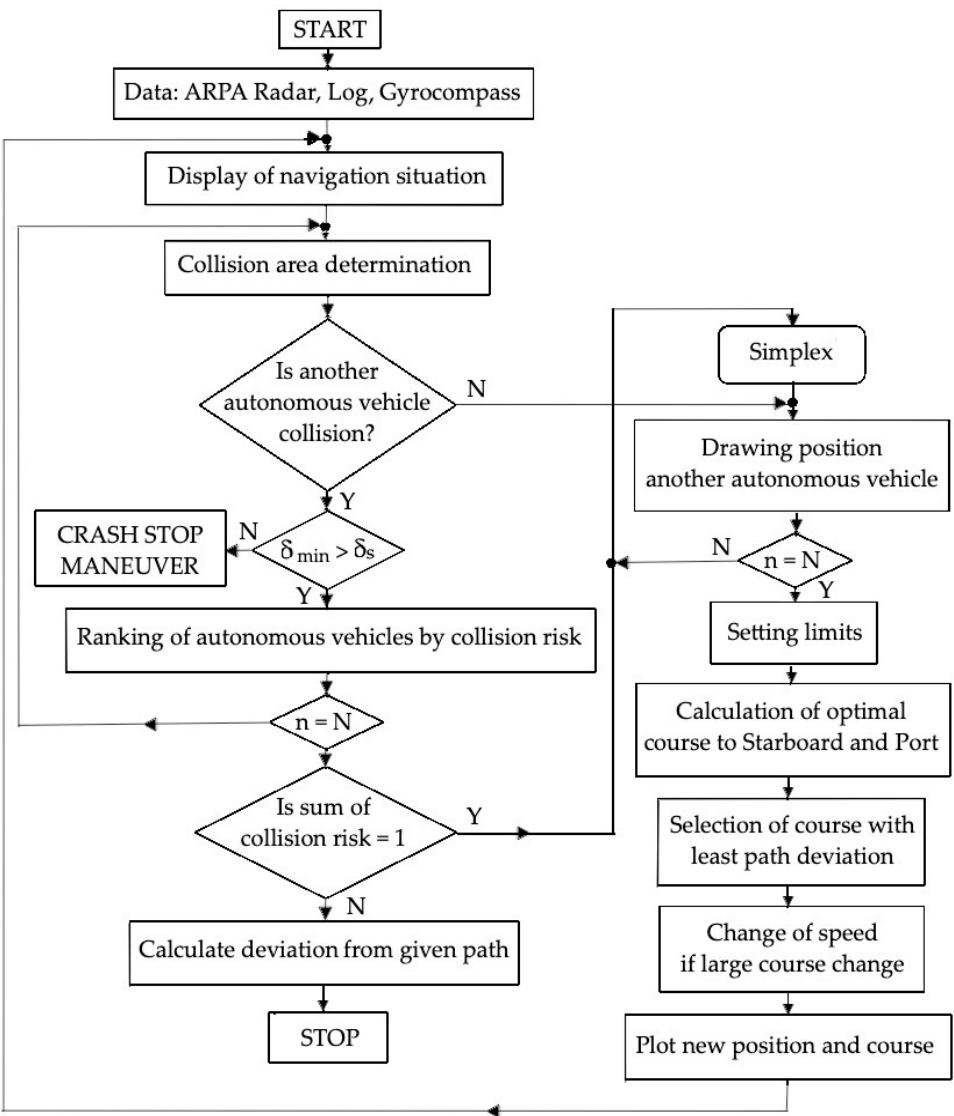
Figure 4. Block diagram of the KO algorithm for determining a safe kinematic trajectory in a group of autonomous vehicles.